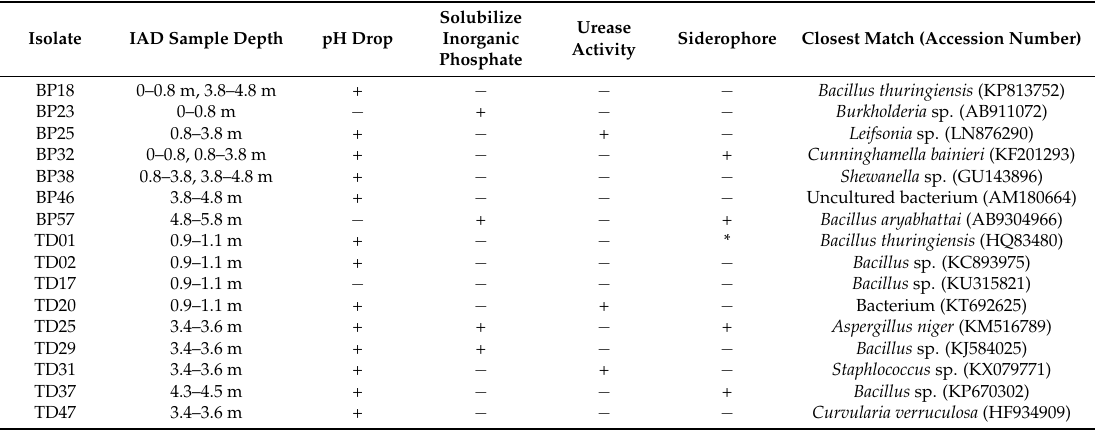
Table 3. Characterization of isolates from Madagascan IAD. BP isolated are from profile overlying the volcanic breccia and TD isolates are from profile overlying the country rock. Closest matching sequences were obtained from GenBank in June (BP46, BP57, TD02 and TD05) and remainder in July